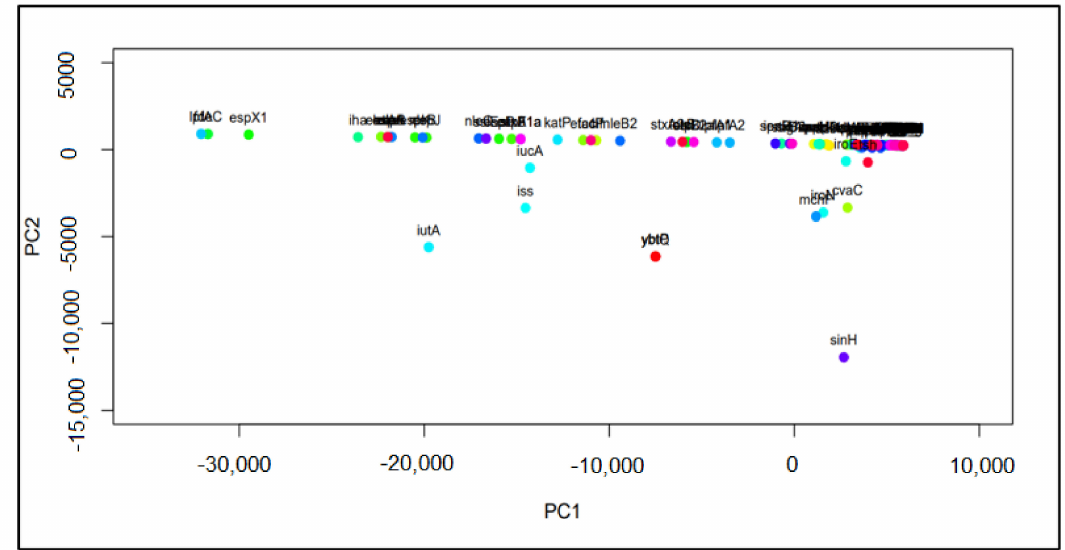
Figure A1. The result from principal component analysis of virulence genes found in samples in the US from 2010–2020. The genes are shown in a PC1~PC2 space, with important genes clustered away from main groupings. While the genes are lumped together here, they can be distinguished, as shown in Figure 2.